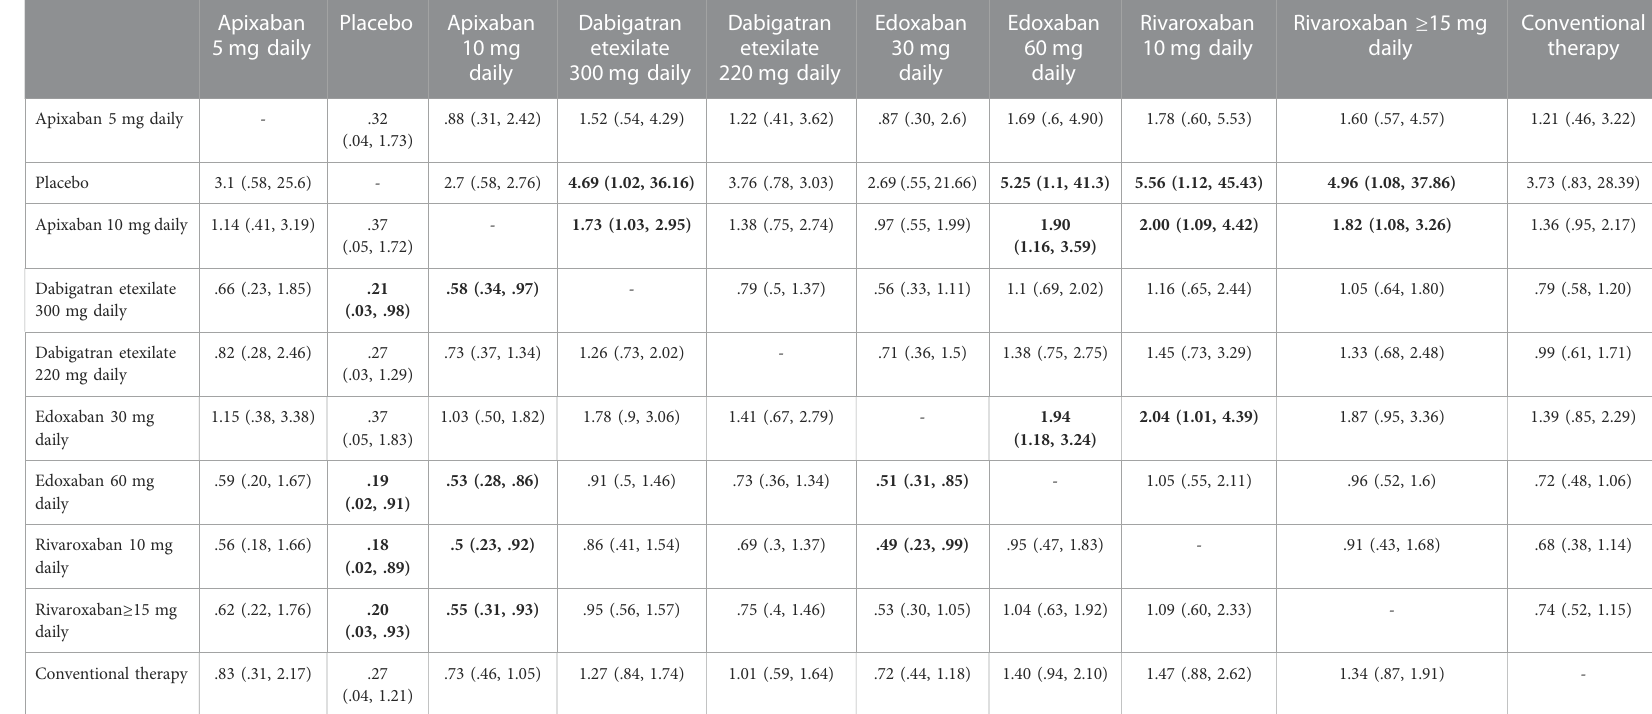
TABLE 2 Estimated relative treatment effects as odds ratio (OR) and corresponding 95% credible intervals.